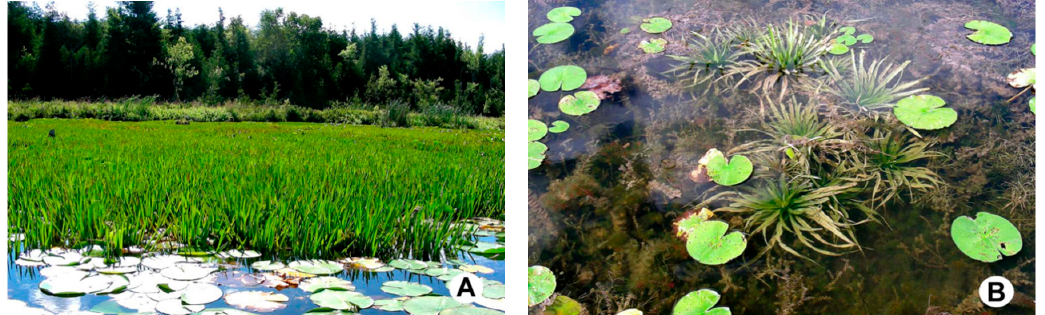
Figure 1. Field photographs showing a dense population of emergent water soldier ( A ) and submerged plants ( B ). Figure reproduced from Snyder et al. [3] (© Canadian Science Publishing or its licensors).